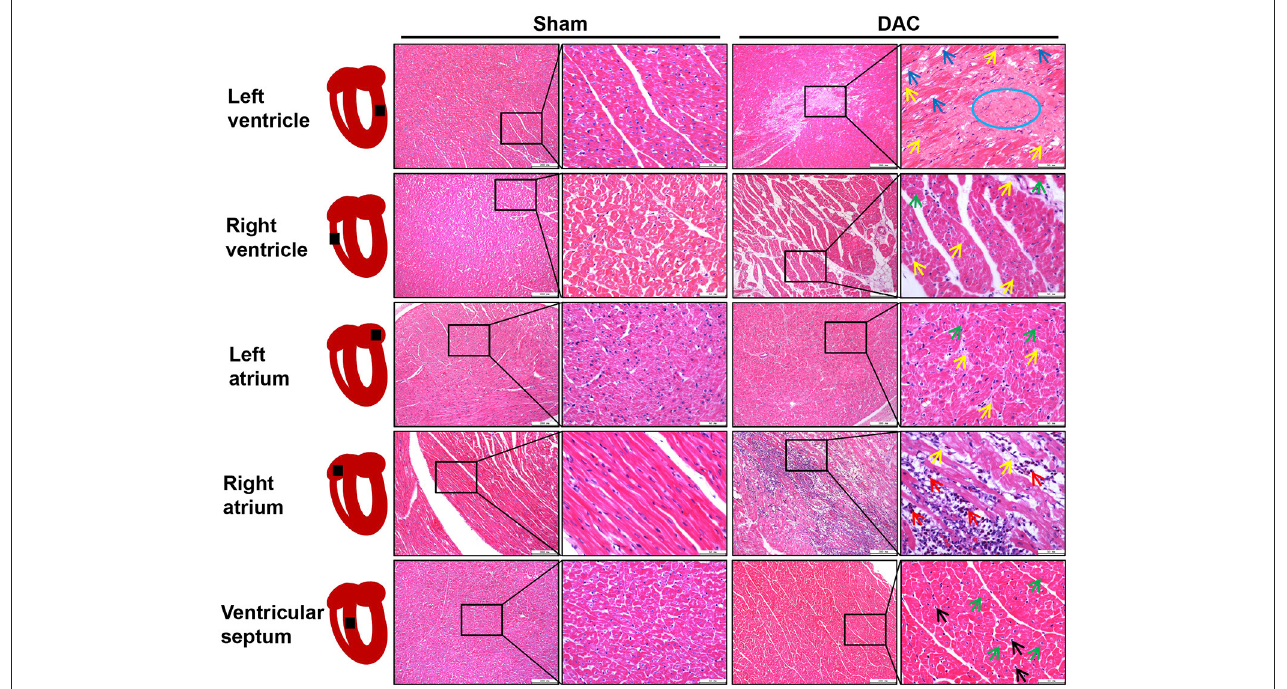
FIGURE 4 | Tissue damage of atria, ventricles, and interventricular septum induced by DAC. There was widespread fibrosis (yellow arrows) in the myocardium of the left and right atria. Cardiomyocyte hypertrophy (green arrows) and eosinophil infiltration (red arrows) were observed in the right atrium. Cardiomyocyte hypertrophy (green arrows) and nuclear pyknosis (black arrows) were observed in the internal ventricular septum. Fibrosis (yellow arrows) was present in the left ventricular myocardium, accompanied by dissolved cardiomyocyte nuclei (blue arrows) and scar (blue circle) appearance. The right ventricle showed cardiomyocyte hypertrophy (green arrows) and interstitial fibrosis (yellow